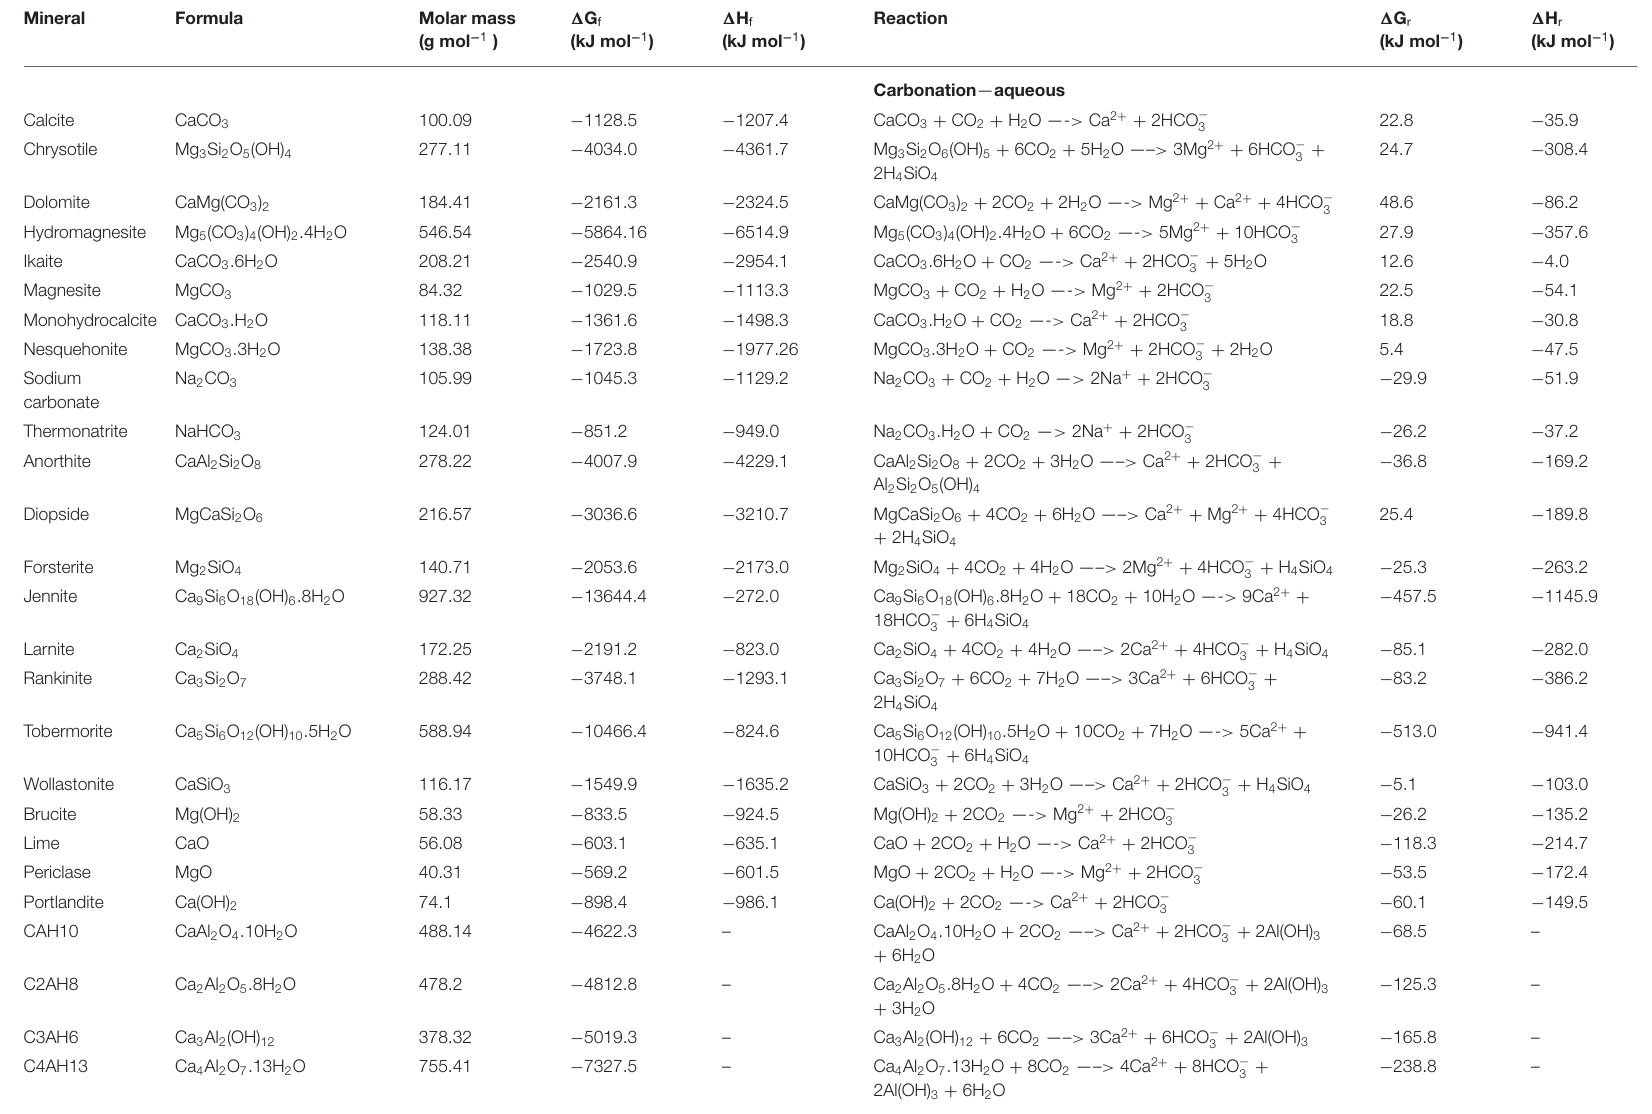
TABLE 1 | Mg-, Ca-, Na- silicate, oxide, hydroxide, aluminate, carbonate, etc., minerals typically encountered in geochemical NETs, with their Gibbs free energies ( 1 G f ) and enthalpies ( 1 H f ) of formation (Robie and Hemingway, 1995), and in some cases their Gibbs free energies ( 1 G r ) of reaction with H 2 O and CO 2 , at 1 atm and 25 ◦ C [calculated using data from Robie and Hemingway